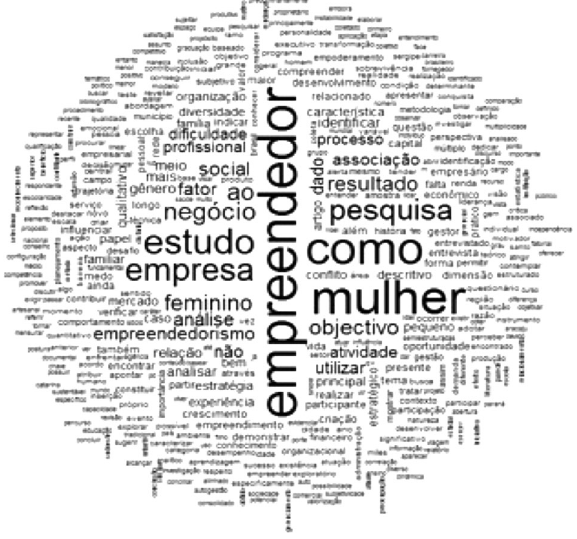
Fig. 4 Word Cloud of absolute frequency of words in papers published in